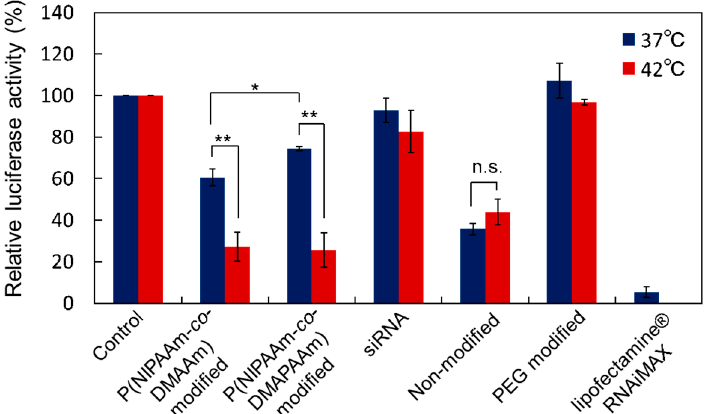
Figure 8. Effect of temperature on gene silencing activity of Luc-HeLa cells transfected with Luc-siRNA. siRNA was transfected for 4 h at 37 °C or 42 °C using liposomes and lipofectamine RNAiMAX. The charge ratio (+/ − ) was 5:1 and the siRNA concentration was 25 nM. The data are mean ± standard deviation (SD). ( n = 3 or 4, ** p < 0.01, * p < 0.05, and n.s.: not significant).